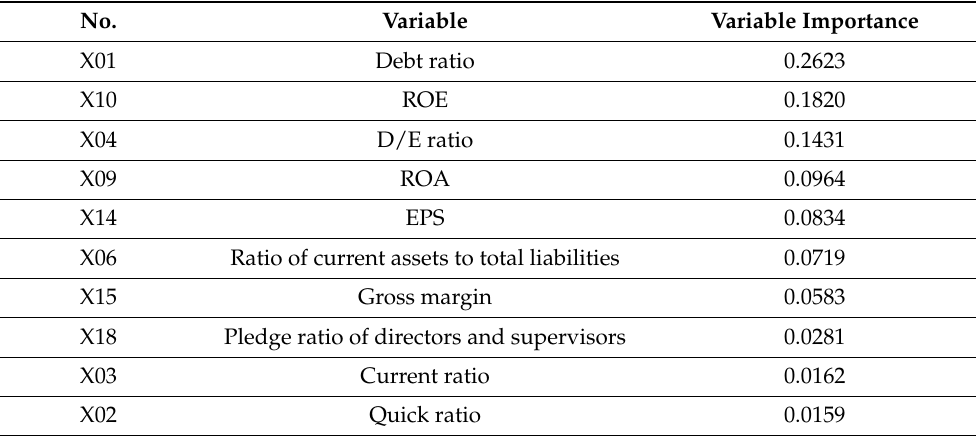
Table 3. Important variables selected by